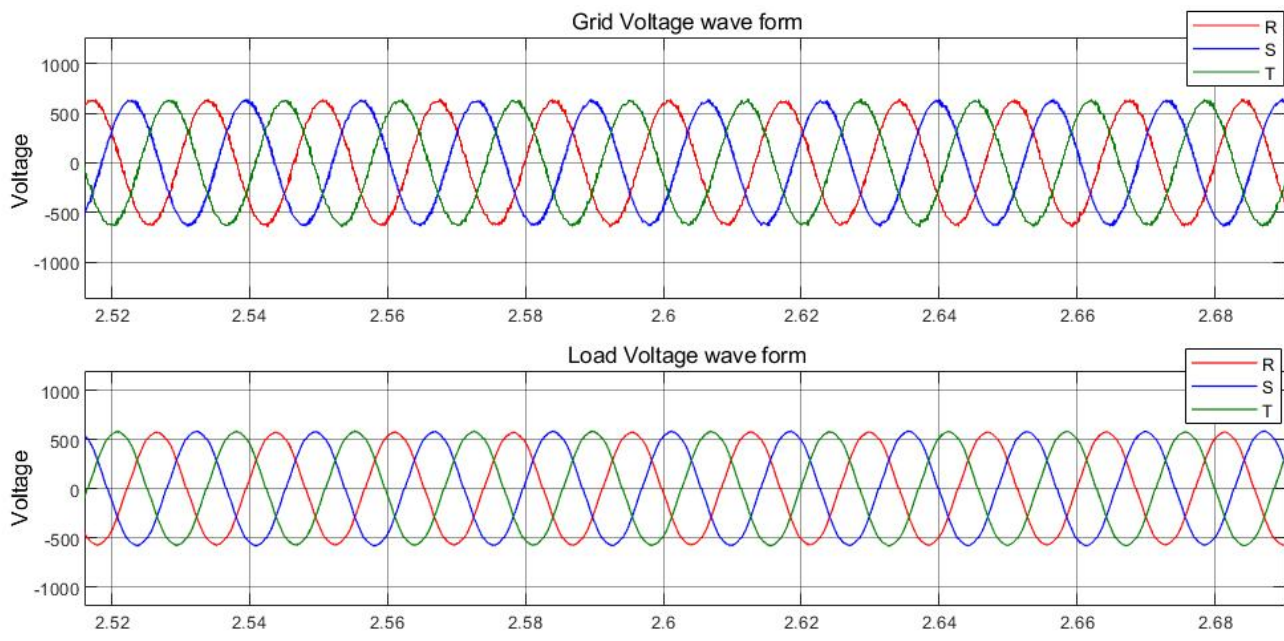
Figure 12. Load ‐ side voltage and grid ‐ side voltage with non ‐ linear load on the grid side using hysteresis.